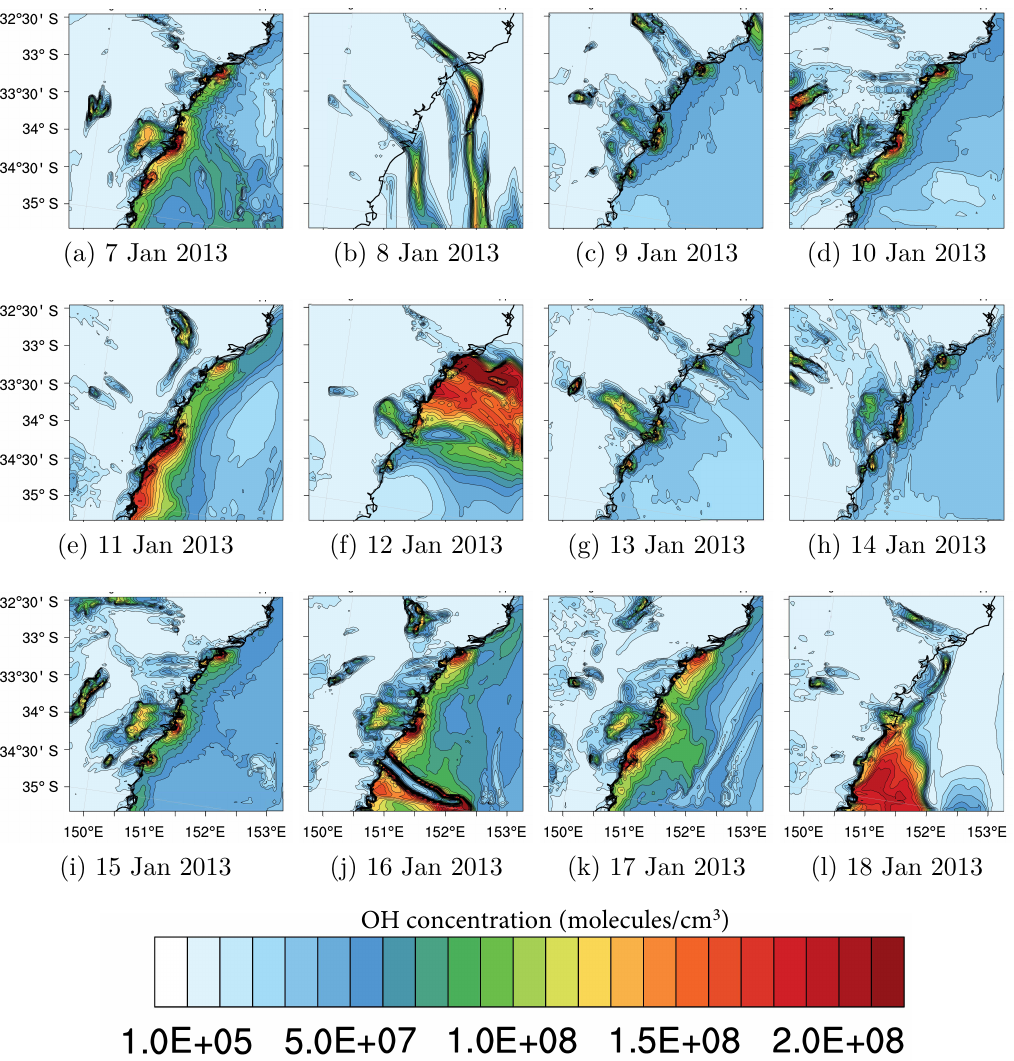
Figure 9. Simulated surface hydroxyl (OH) radical concentrations from 7 January to 18 January 2013 at 3:00 p.m. local